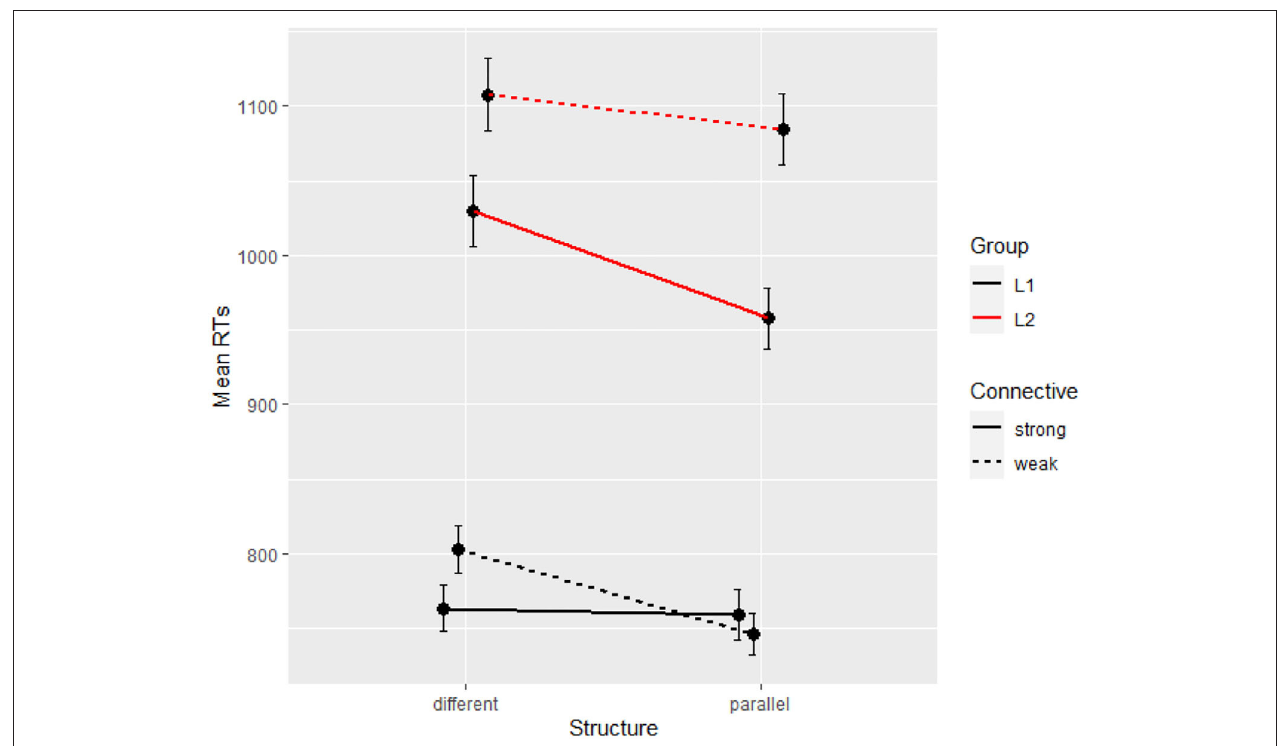
FIGURE 6 | Mean reading times per condition and per group (Experiment 3, Segment